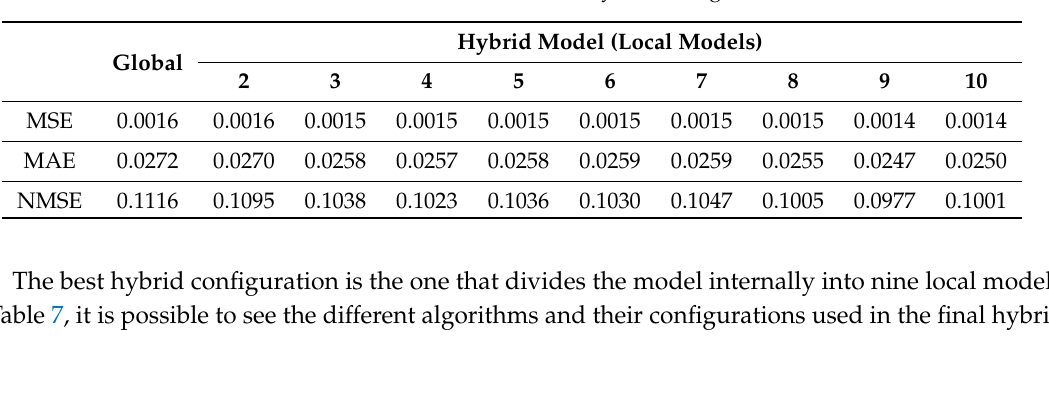
Table 8. Error values for the different hybrid